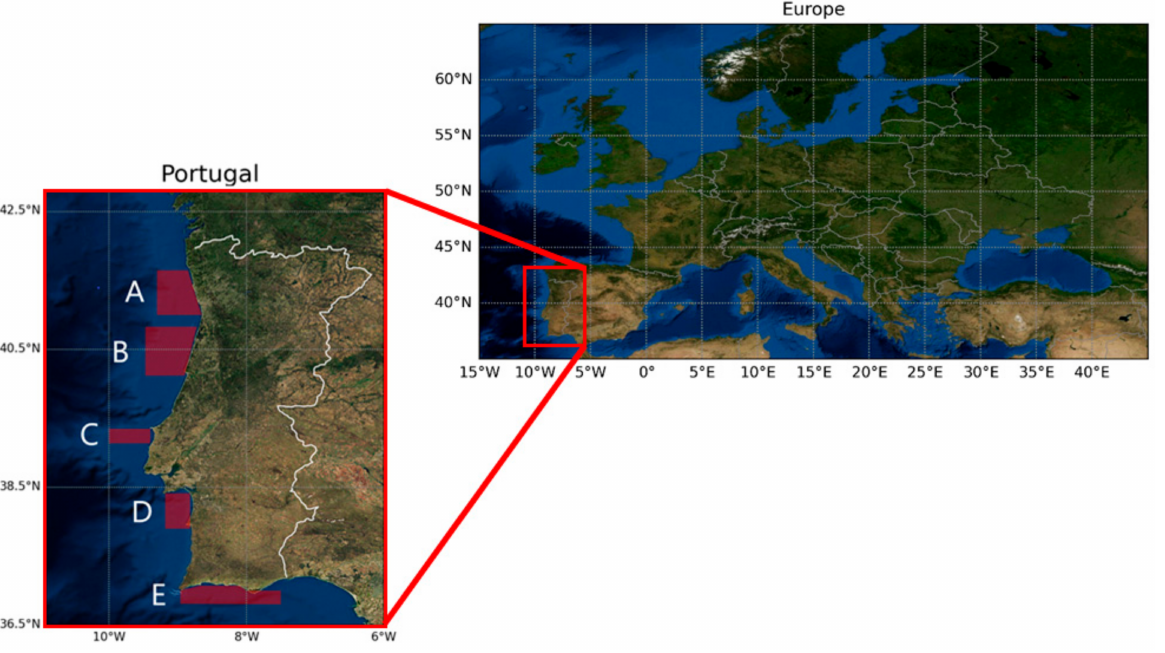
Figure 1. Framing of Portugal within Europe and location of the 5 study regions along the Portuguese